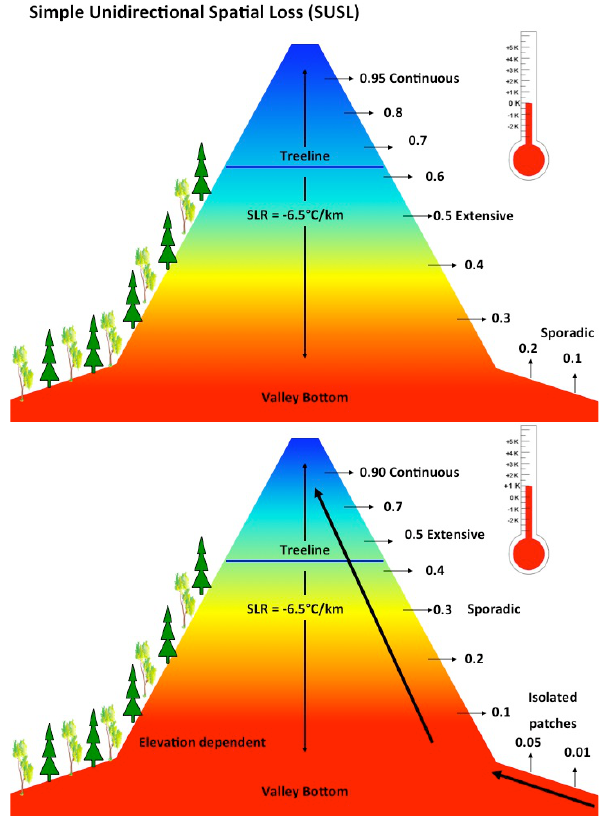
Fig. 11. (Upper) Conceptual diagram of permafrost probability vari- ation in an area susceptible to simple unidirectional spatial loss; (lower) equilibrium permafrost probabilities following a warming scenario.